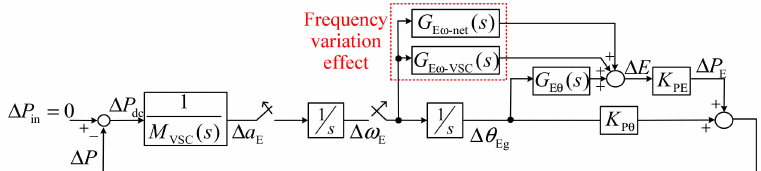
Figure 12. Converting the e ff ect of amplitude dynamics into the VSC’s phase motion (including the e ff ect of frequency